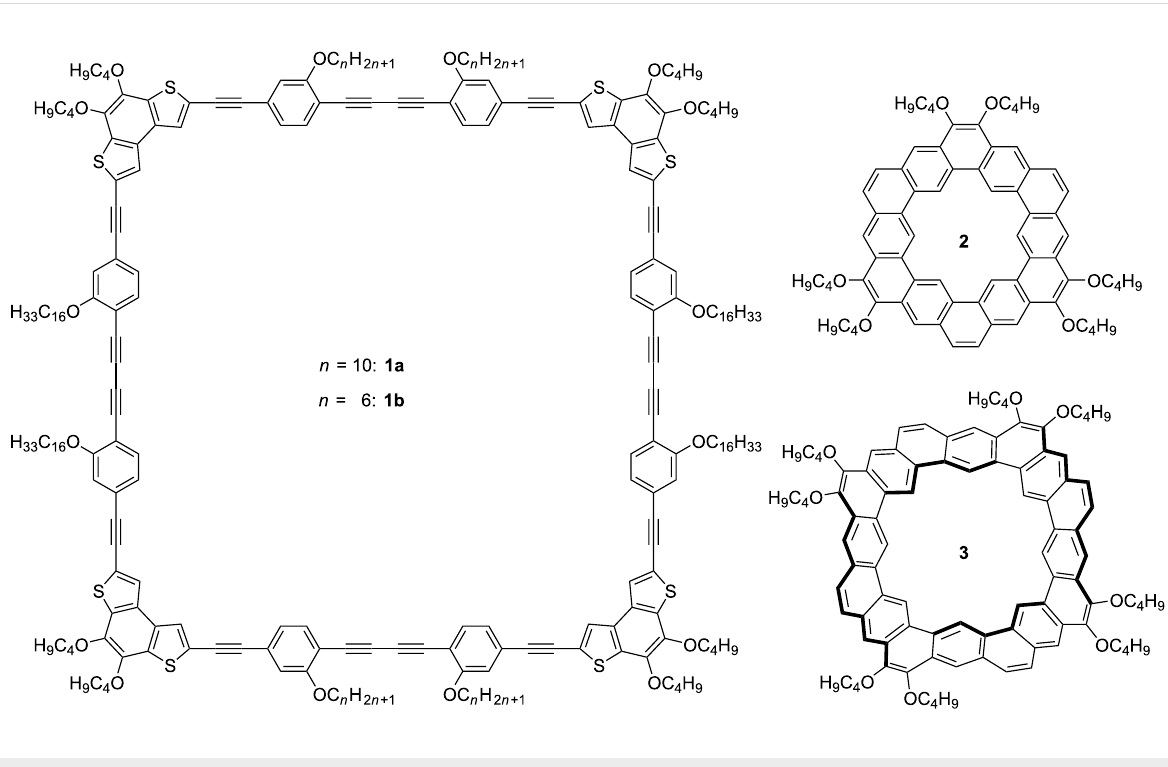
Figure 1: Chemical structures of the molecular squares 1a / b , the kekulene derivative 2 , and octulene derivative 3